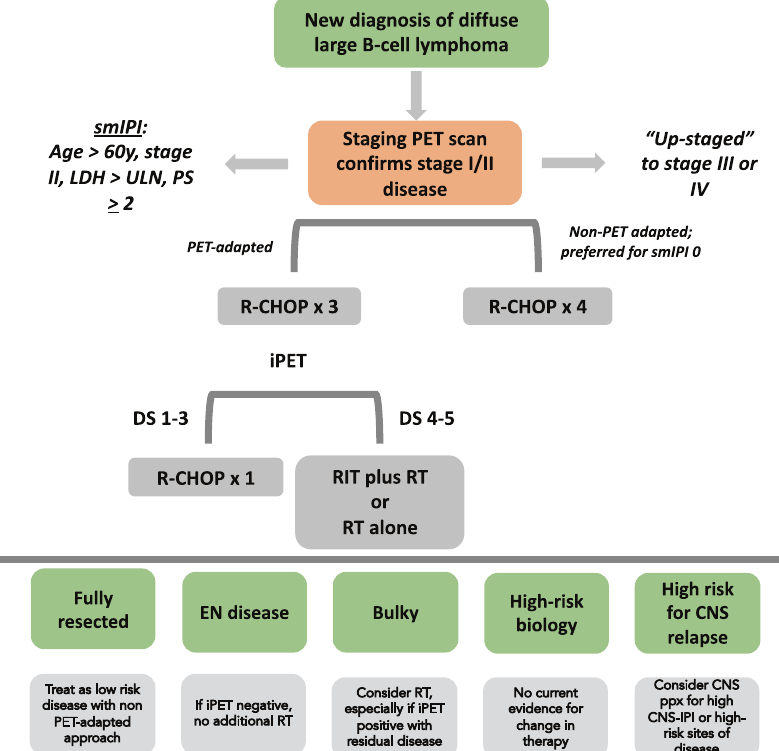
Fig. 1 Our approach to the management of limited stage diffuse large B-cell lymphoma (DLBCL). Abbreviations: iPET interim PET, smIPI stage modi fi ed IPI, RIT radioimmunotherapy, DS Deauville score, ppx prophylaxis, PS performance status, ULN upper limit